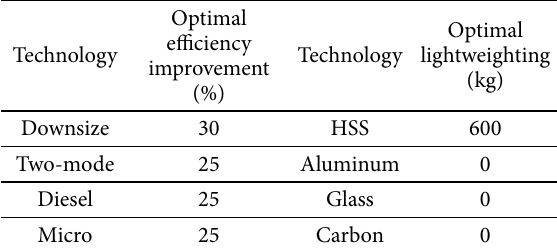
Table 2. Optimal levels of technology implementation using discrete optimization